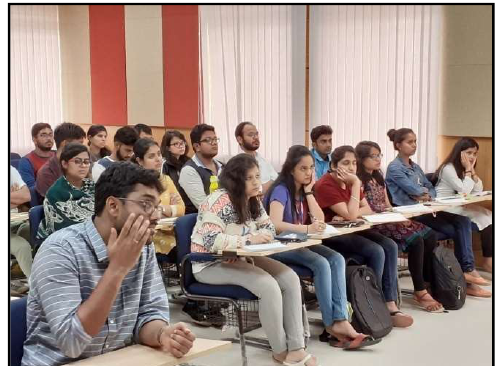
Figure 5. Participants attending live lecture at NESAC